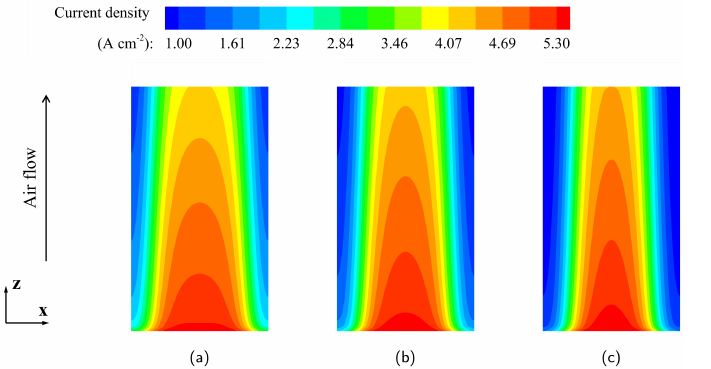
Figure 16. Impact of the LCWR on the current density over the middle plane of the MEM: